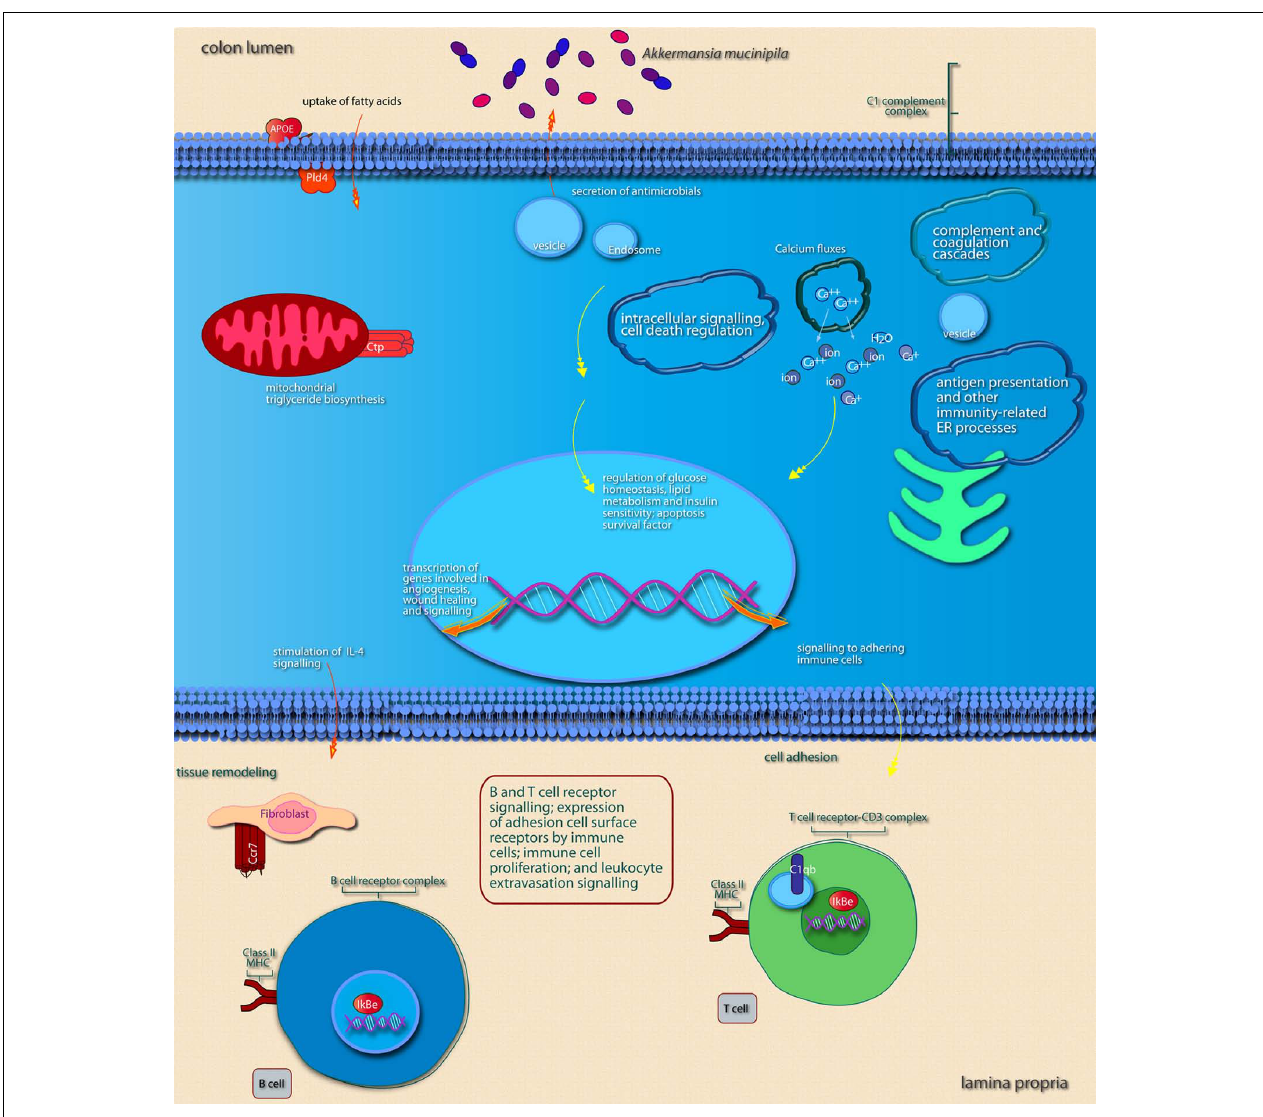
FIGURE 6 | Main cellular pathways and processes inferred to be modulated or activated after colonization of mouse colon by A. muciniphila . Distinguishing features are the induction of pathways involved in intracellular signaling, induction of secretion of (antimicrobial) factors, and of pathways that promote expression of immune cell receptors that mediate adhesion andT or B cell receptor signaling. For further explanation, see legend of Figure 5